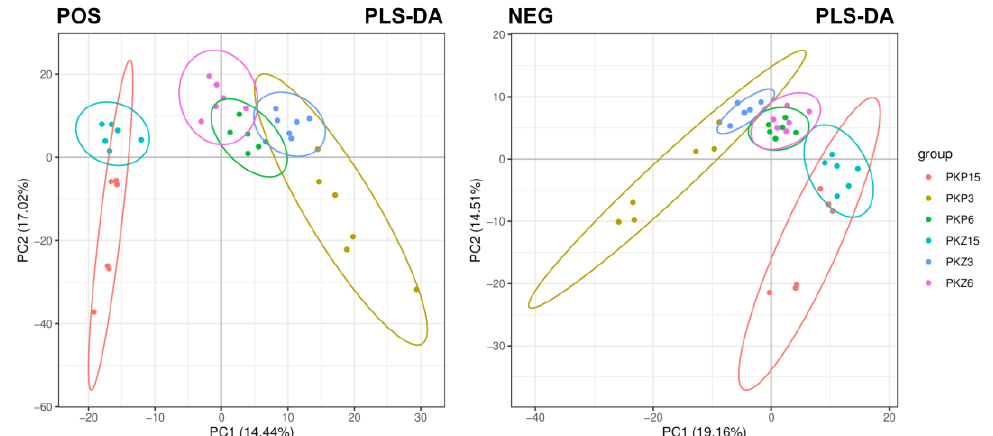
Figure 2. PLS-DA score plot of total samples in positive and negative ion modes. PC1: principal component 1; PC2: principal component 2. Scatter points of different colors represent samples of different experimental groups; the ellipse is the 95% confidence interval. PKP3–PKZ15 is the same as in Table 1. POS: positive ion mode; NEG: negative ion